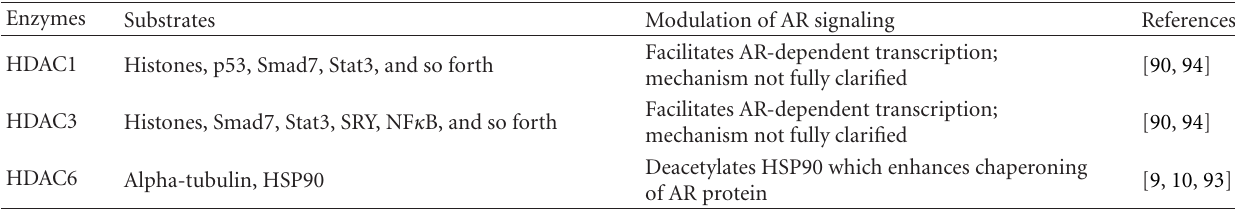
Table 2: List of HDACs that play a role in AR